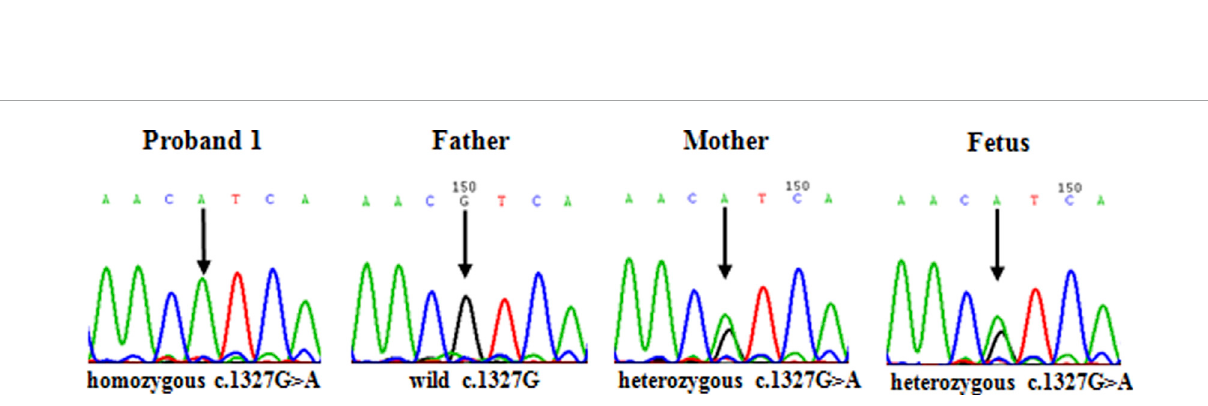
D15SFES in proband 1. The results of the linkage analysis are shown in Figure 6. Because D15S646, D15S817, D15S1513, and D15S822 are located between breakpoint 2 and breakpoint 3 of the PWS/AS chromosomal region and D15S659 and D15SFES are outside the region, these results suggested that a microdeletion was present on chromosome 15, smaller than that of the internationally reported Class